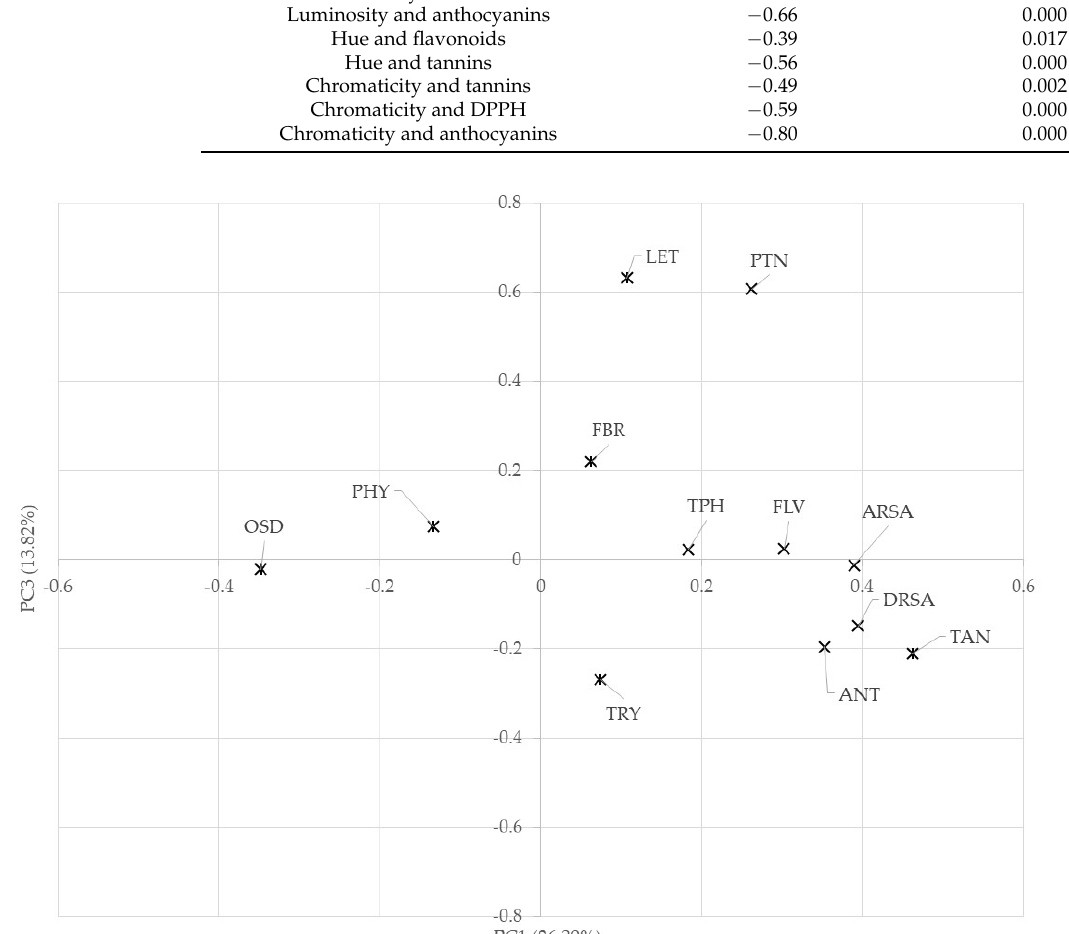
Figure 4. Principal component analysis of total phenolic (TPH), flavonoid (FLV), anthocyanin (ANT), tannin (TAN), phytic acid (PHY), oligosaccharide (OSD), lectin (LET), trypsin inhibitory activity (TRY), raw fiber (FBR), protein (PTN) and radical scavenging activity (ARSA, DRSA) from Phaseolus accessions collected.